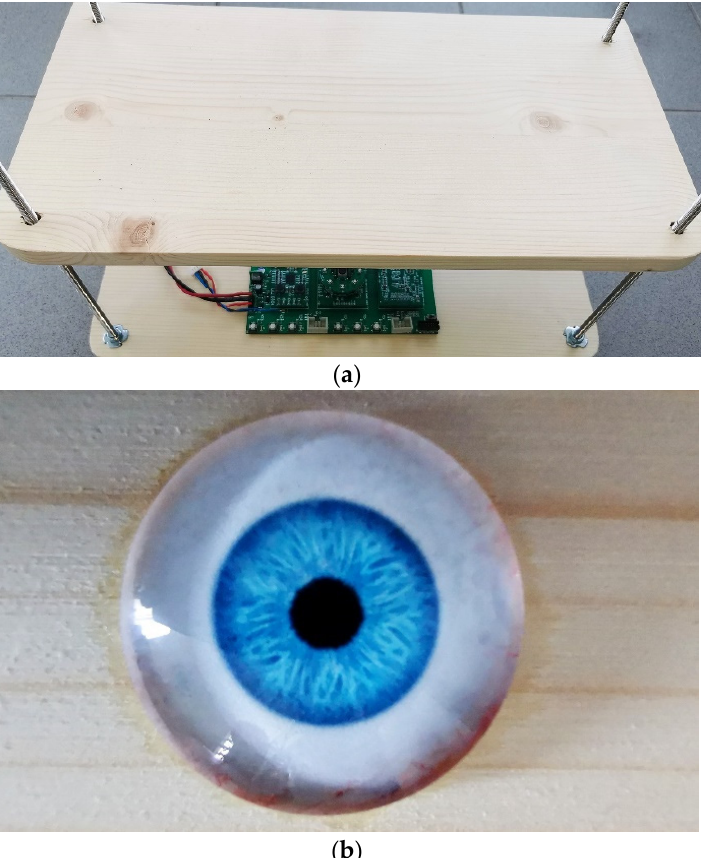
Figure 9. Eye image acquisition experimental setup: ( a ) developed prototype electronics under the toy eye; ( b ) toy eye glued on the top board.